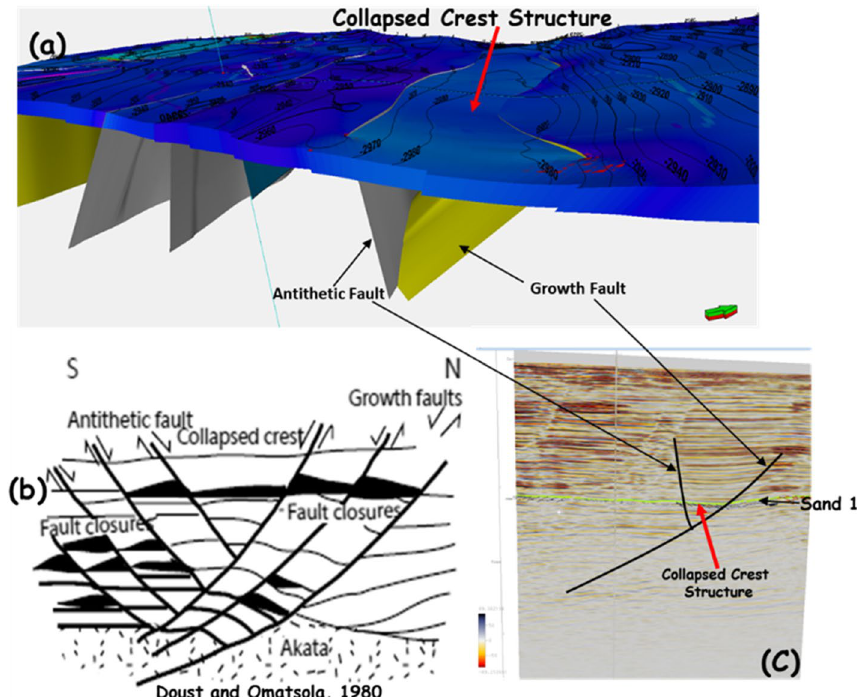
Fig. 21 Structural model of collapsed crest structure on sand